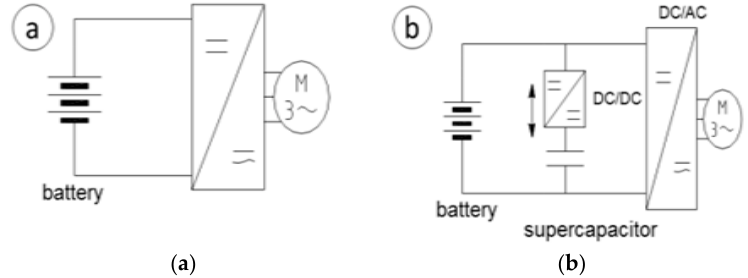
Figure 5. Architectures for the hybrid storage: ( a ) Battery Based; ( b ) Hybrid ESS solution